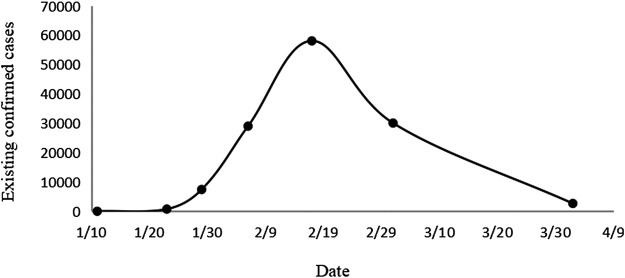
Trends in the number of confirmed cases over time.